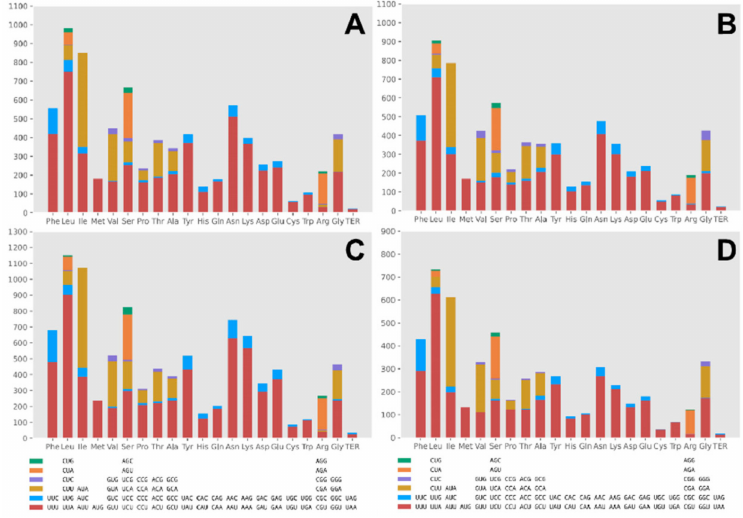
Figure 5. Codon usage analysis of the mitochondrial genomes from four Clonostachys species. (( A – D